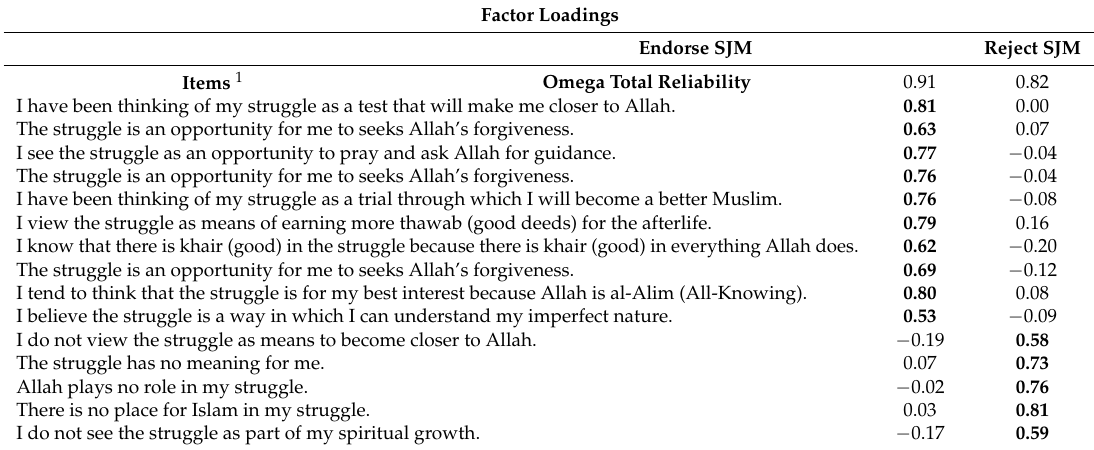
Table 3. Summary of Exploratory Factor Analysis of the Spiritual Jihad Measure Using Ordinary Least Squares Estimation from a Polychoric Correlation Matrix and Direct Oblimin